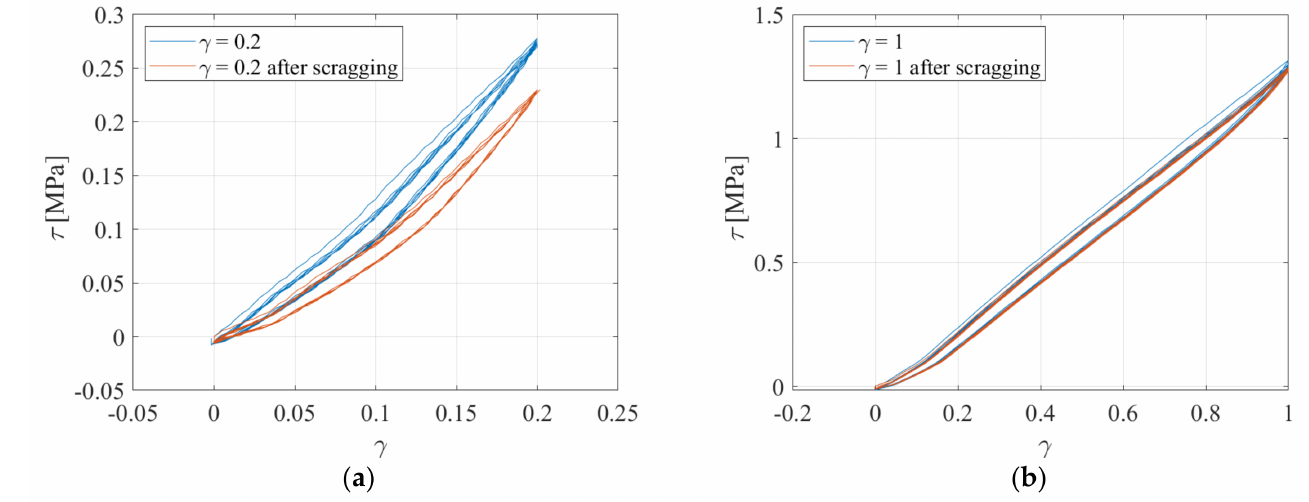
Figure 16. Stress − strain curves for ( a ) 20% and ( b ) 100% of nominal shear